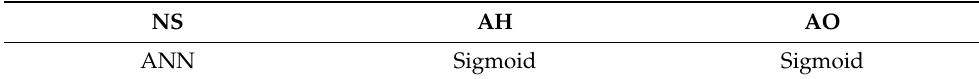
Table 2. ANN network model.